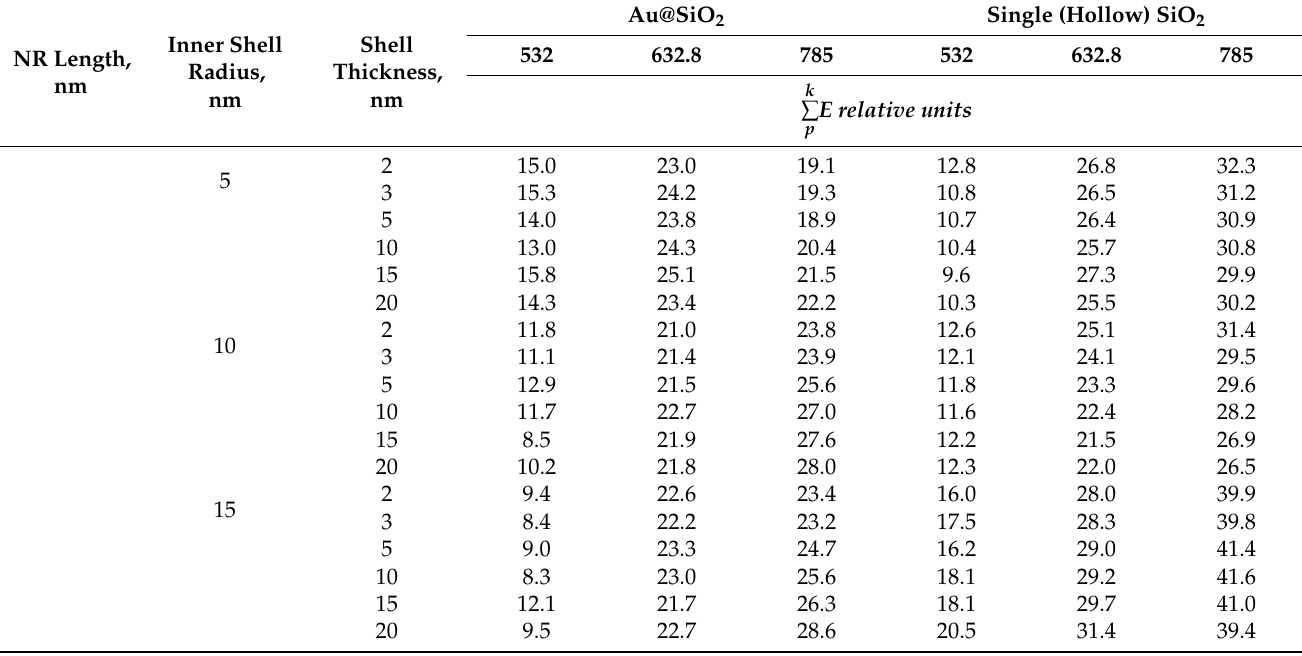
Table 5. The integral sum of the electrical field is distributed near the surface of the NRs and SiO 2